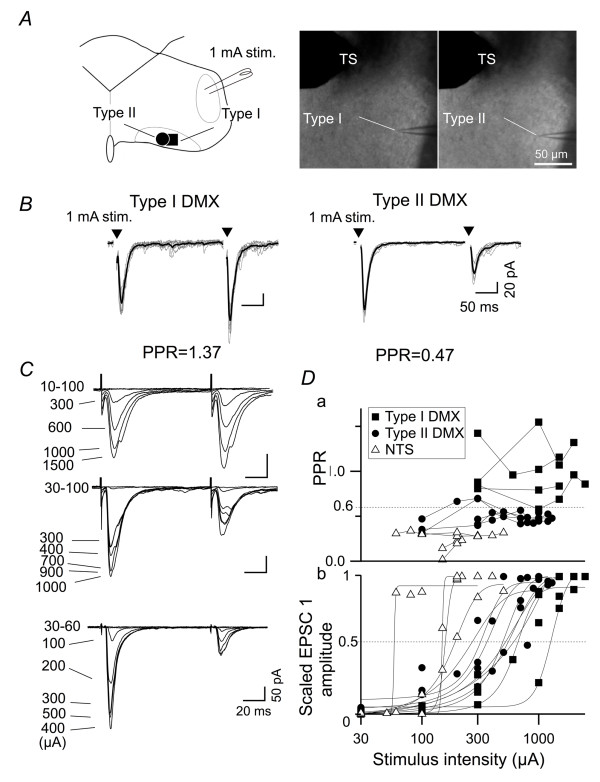
Effect of stimulation protocol, electrode position and stimulus intensity on the PPR values. A, left, schematic representation of the location of the two DMX neurons in which the EPSCs were evoked by stimulation at 1-mA intensity, which was delivered by the stimulating electrode placed on the TS. This electrode was never moved and the stimulation intensity was never changed during the recording of either DMX neuron. Right, IR-DIC images showing that two DMX neurons were located close to each other and the stimulation electrode on the TS was not moved. B, EPSC waveforms recorded from a type I (left) and type II (right) DMX neuron. Overlaid consecutive responses and the average trace (n = 8) in response to paired stimuli (arrowheads) at an interstimulus interval of 100 ms. Values on the bottom indicate the PPR. These results indicate that the distinct types of short-term plasticity in the DMX neurons do not depend on the intensity and site of stimulation. C, superimposed EPSC traces recorded from a type I DMX neuron (top), a type II DMX neuron (middle) and a dm-cNTS neuron (NTS; bottom) evoked by distinct stimulation intensities. EPSC1 and EPSC2 amplitudes gradually increased and reached the maximal amplitude. D, relationship between stimulus intensity and PPR (a) and normalized EPSC1 amplitude (b) that was measured in type I DMX (n = 4), type II DMX (n = 5) and dm-cNTS neurons (n = 4). Note that, despite marked increases in EPSC1 amplitude upon increasing stimulation intensity, the classification of neurons according to the PPR value was essentially unaffected, especially beyond the stimulus intensity that yielded 50%-EPSC1 amplitudes (50%-stimulus intensity).